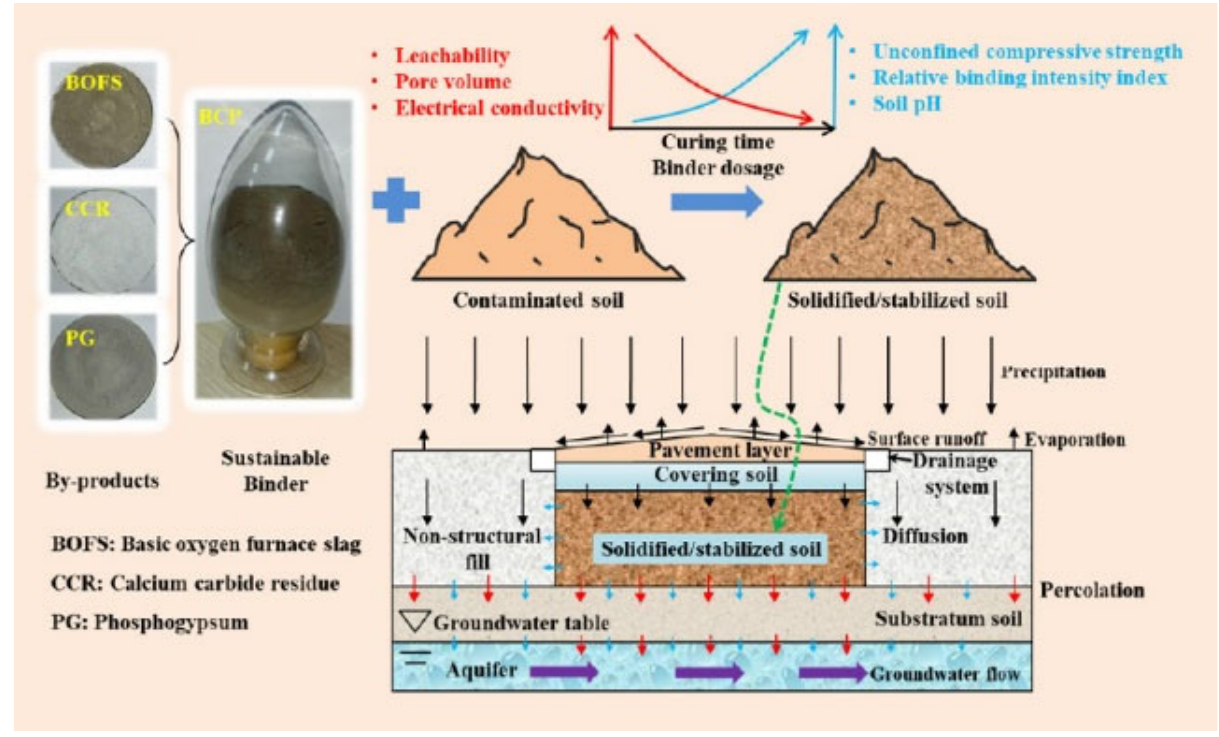
Figure 6: A graphical representation of the BCP binders.